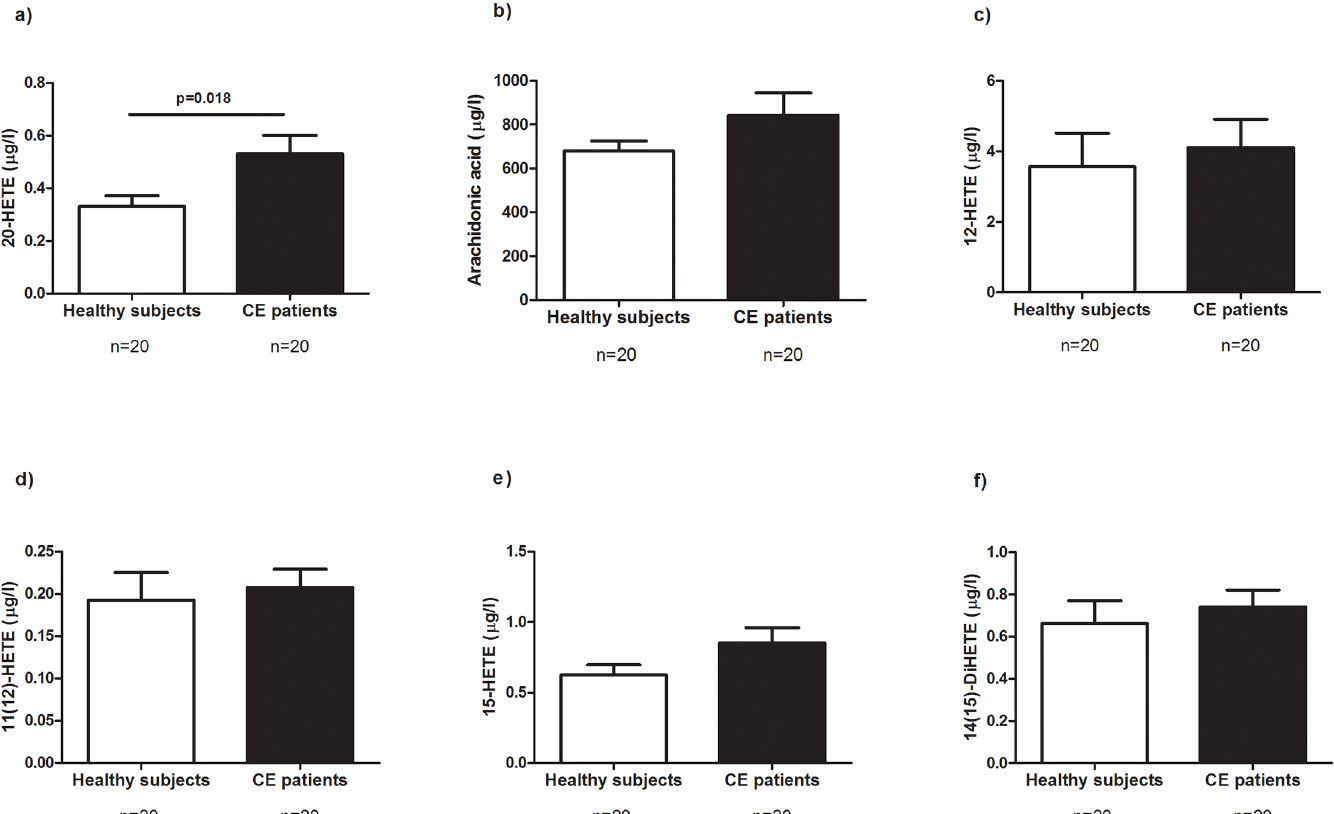
Fig 1. Plasma levels of metabolites in healthy subjects and in patients who underwent carotid endarterectomy (CE): ( a ) 20-HETE; ( b ) Arachidonic acid; ( c ) 12-HETE; ( d ) 11(12)-DiHETE; ( e ) 15-HETE; ( f ) 14(15)-DiHETE. p < 0.05 was considered to be statistically significant. HETE, hydroxyeicosatetranoic acid.